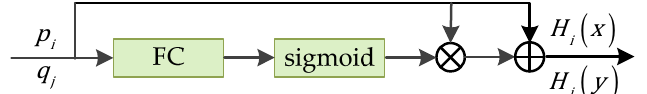
Figure 7. The structure of cross-modal attention mechanism (CMAM). p i and q j are the input features of CMAM for image subnetwork and text subnetwork, H i ( x ) and H j ( y ) are the output features respectively, FC denotes full connection layer, ⊗ denotes element-wise product, and ⨁ denotes element-wise sum.